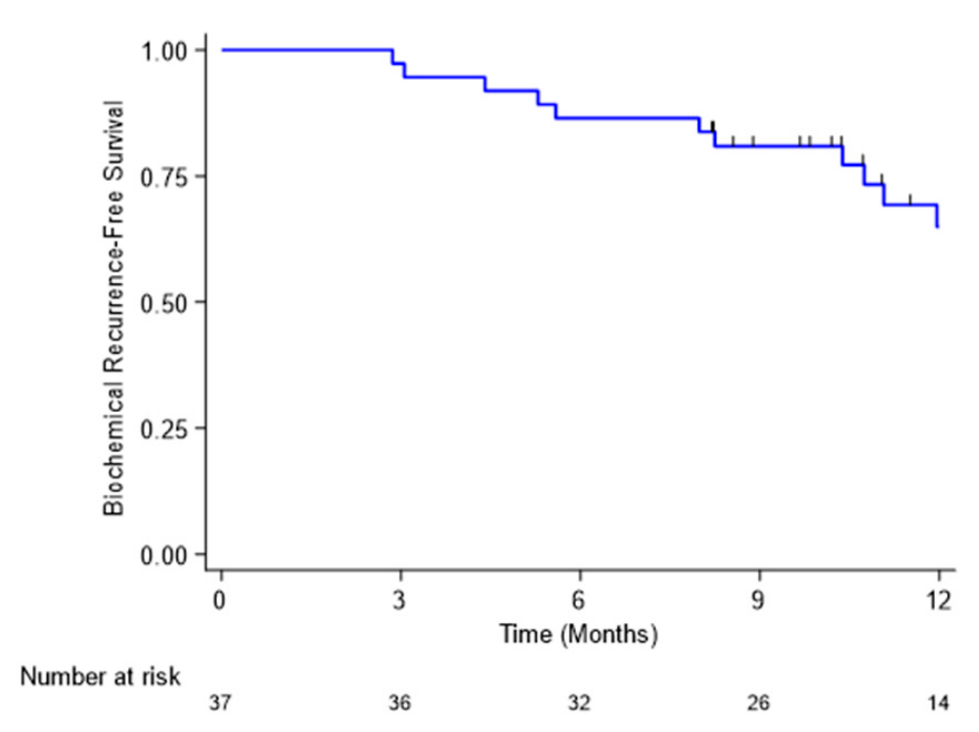
Figure 1. Biochemical recurrence-free survival curve. Recurrence was defined as an increase of PSA level of more than 50% compared to nadir post-reirradiation.